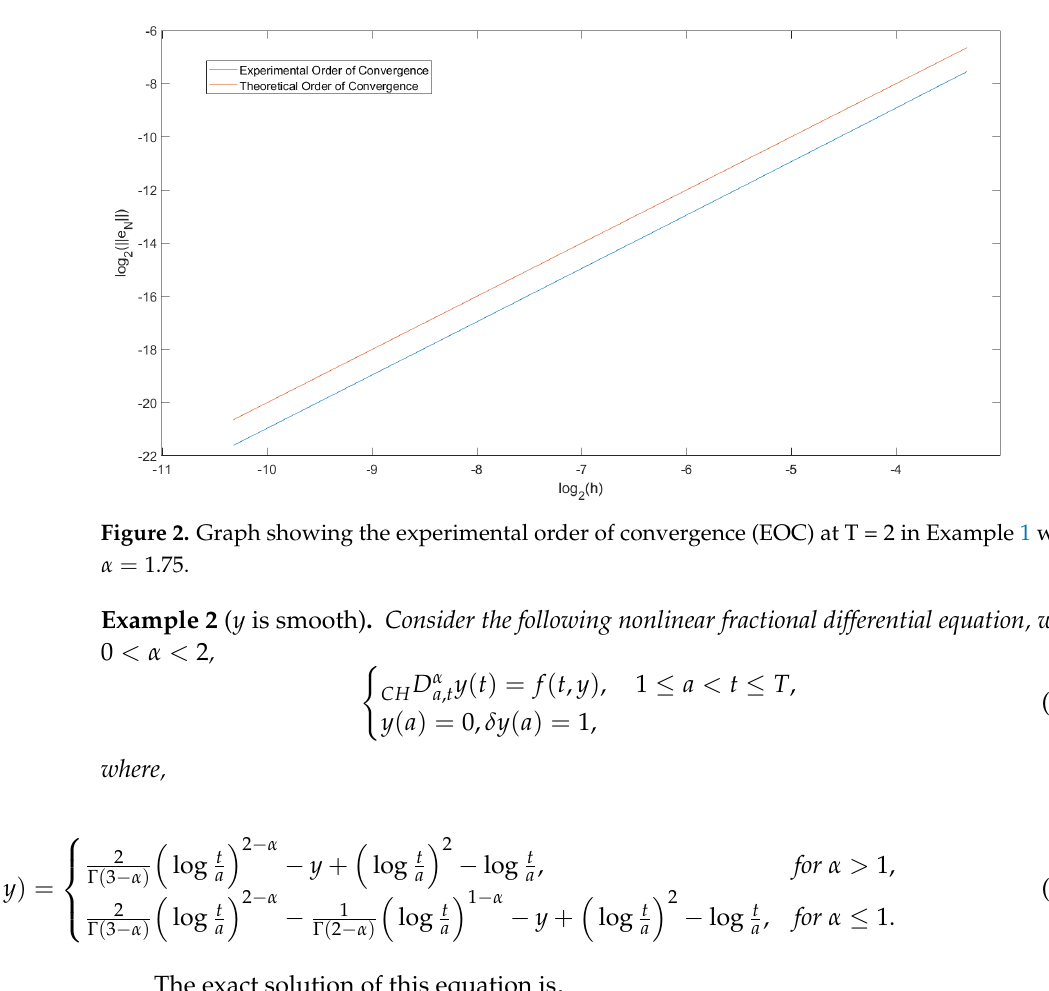
Figure 1. Graph showing the experimental order of convergence (EOC) at T = 2 in Example 1 with α = 0.8.